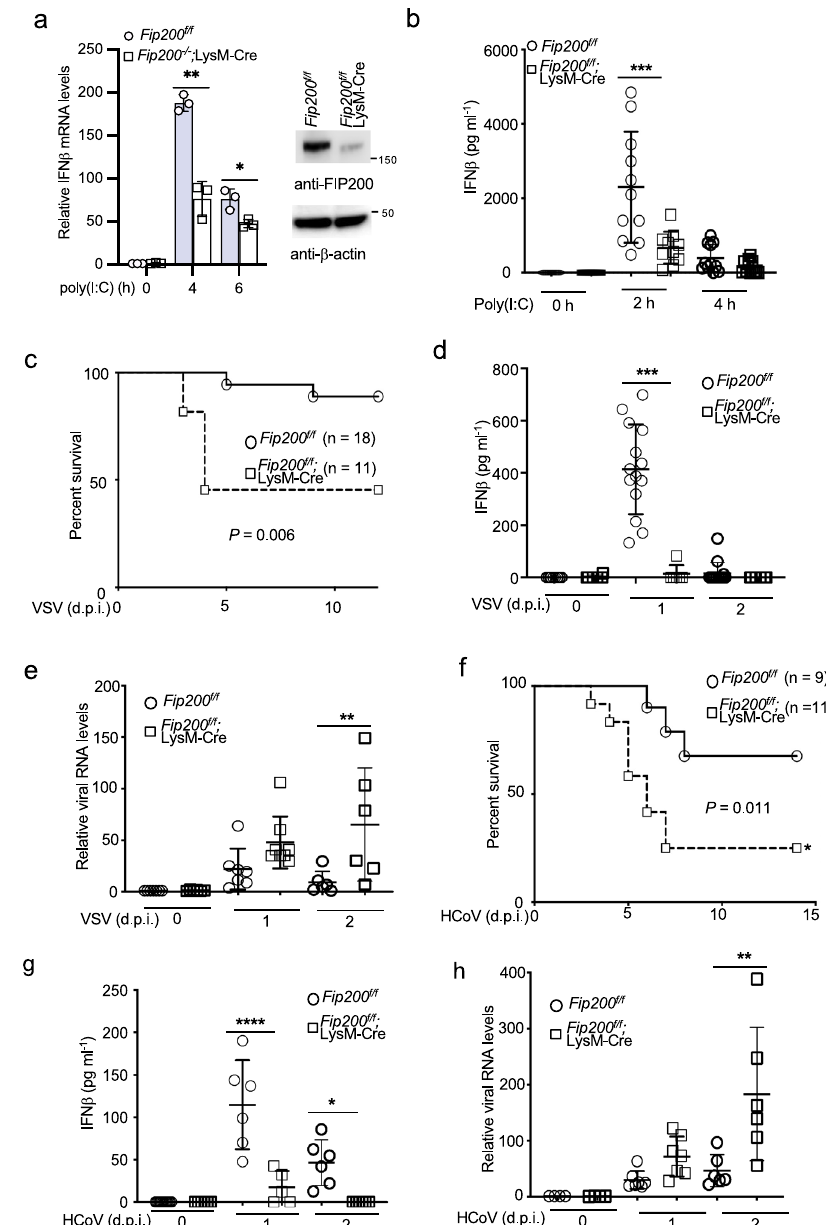
Fig. 7 FIP200 is required for innate host defense to RNA virus infection in vivo. a The BMDMs of Fip200 f/f and Fip200 f/f ; LysM-Cre mice were stimulated with 1 μ g ml − 1 of poly(I:C) for indicated times. Real-time PCR was performed to determine the relative IFN β mRNA levels. Data represent means ± s.d. of three independent experiments. The P -value was calculated (two-tailed Student ’ s t test) by comparison with the wild-type cells. * P < 0.05, ** P < 0.01. The right panel shows the knockout ef fi ciency by Western blotting. b Fip200 f/f and Fip200 f / f ; LysM-Cre mice were injected with 50 μ g of poly(I:C) plus 6 μ l of in vivo-jetPEI via tail vein for designated times. Blood was collected for IFN β ELISA assay. *** P < 0.001, by one-way ANOVA, followed by Tukey ’ s multiple comparison test. c Survival curve of VSV-infected Fip200 f/f and Fip200 f/f ; LysM-Cre mice. Eighteen Fip200 f/f mice and eleven Fip200 f/f ; LysM-Cre mice were infected with 2 × 10 5 TCID 50 of VSV intravenously. Mice were monitored at the indicated d.p.i. P = 0.006, calculated by Mantel – Cox log-rank test. d Fip200 f/f and Fip200 f/f ; LysM-Cre mice were infected with 2 × 10 5 TCID 50 of VSV intravenously. Blood was collected for IFN β ELISA assays at 0, 1, and 2 d.p.i. *** P < 0.001, by one-way ANOVA, followed by Tukey ’ s multiple comparison test. e Fip200 f/f and Fip200 f/f ; LysM-Cre mice were infected with 2 × 10 5 TCID 50 of VSV intravenously. Brain tissues were collected for RNA extract. VSV RNA levels were determined by real-time PCR. ** P < 0.01, by one-way ANOVA, followed by Sidak ’ s multiple comparisons test. f Survival curve of HCoV OC43-infected Fip200 f/f and Fip200 f/f ; LysM-Cre mice. Nine Fip200 f/f mice and elven Fip200 f/f ; LysM-Cre mice were infected with 1 × 10 5 TCID 50 of HCoV OC43 intracerebrally. Mice were monitored at the indicated day post- infection (d.p.i.). P = 0.011, calculated by Mantel – Cox log-rank test. g Fip200 f/f and Fip200 f/f ; LysM-Cre mice were infected with 1 × 10 5 TCID 50 of HCoV OC43 intravenously. Blood was collected for IFN β ELISA assays at 0, 1, and 2 d.p.i. * P < 0.05, **** P < 0.0001, by one-way ANOVA, followed by Tukey ’ s multiple comparison test. h Fip200 f/f and Fip200 f/f ; LysM-Cre mice were infected with 1 × 10 5 TCID 50 of HCoV OC43 intravenously. Brain tissues were collected for RNA extract. HCoV RNA levels were determined by real-time PCR. ** P < 0.01, by one-way ANOVA, followed by Tukey ’ s multiple comparison